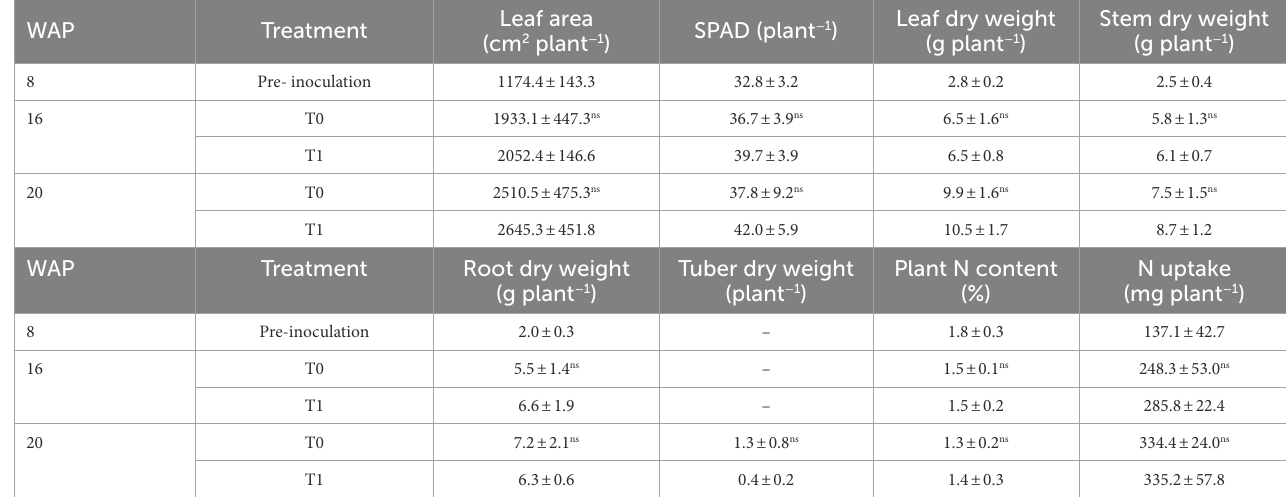
Values represent means followed by the standard deviation. “ns” indicates no significant difference on the same sampling date according to the T test ( p = 0.05). WAP, weeks after